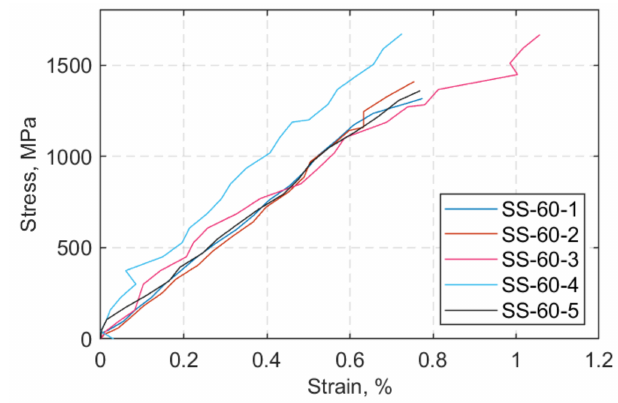
Figure 16. Stress (Mpa) vs. strain (%) at 60 ◦